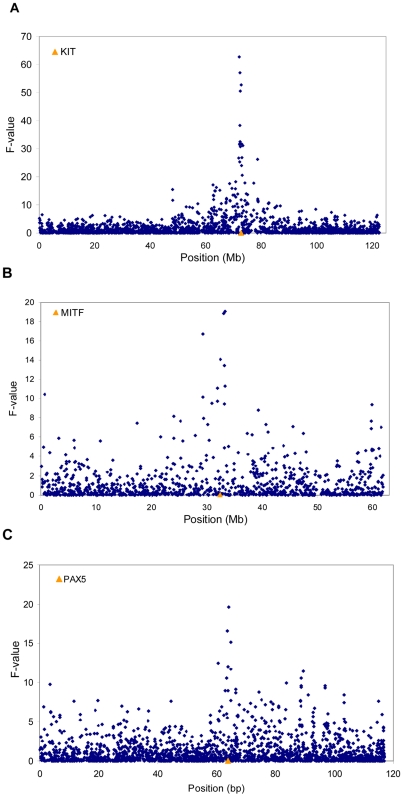
Genome-wide association study for proportion of black.Results for (A) chromosome 6, (B) chromosome 22, and (C) chromosome 8. The location of the KIT. MITF and PAX5 genes are also indicated.